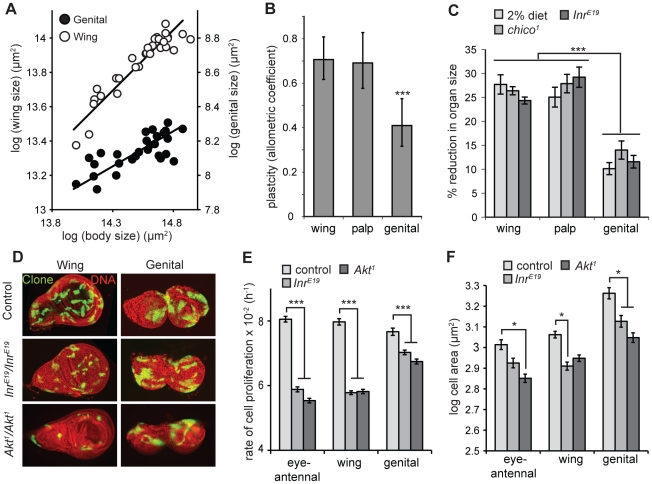
The genitalia of male Drosophila are nutrition- and insulin-insensitive.(A) The scaling relationship for male genital (closed circles) and wing size (open circles) against body size, where size variation is due to variation in developmental nutrition. Each line is the standardized major axis and the slope of this line – the allometric coefficient – captures the nutritional plasticity of wing and genital size relative to the nutritional plasticity of body size. (B) The allometric coefficient is significantly lower for the male genitals than for the wings or the maxillary palps, indicating a reduced nutritional plasticity. *** common slope test, p<0.001. (C) Flies that are homozygous for mutations of Inr or its substrate chico show a significantly smaller reduction in genital size than wing or maxillary palp size, relative to wild-type controls, genocopying starvation (2% diet) (*** Tukey HSD, P<0.001 for all). (D) 48 h wild-type, InrE19 and Akt1 clones in wing and genital discs. Within genotypes, discs are from the same fly. Mutation of Inr or Akt has a greater effect on clone size in the wing disc than in the genital disc. Clones were induced by the MARCM system and express GFP. (E) InrE19 and Akt1 mutant clones proliferate at a slower rate in the eye-antennal and wing imaginal disc than in the genital imaginal disc (*** Tukey HSD, P<0.001 for all). (F) Cell size within InrE19 and Akt1 mutant clones is reduced by more-or-less the same degree in all discs (* Tukey HSD, P<0.05, non-significant comparisons not shown) Error bars are 1 standard error.